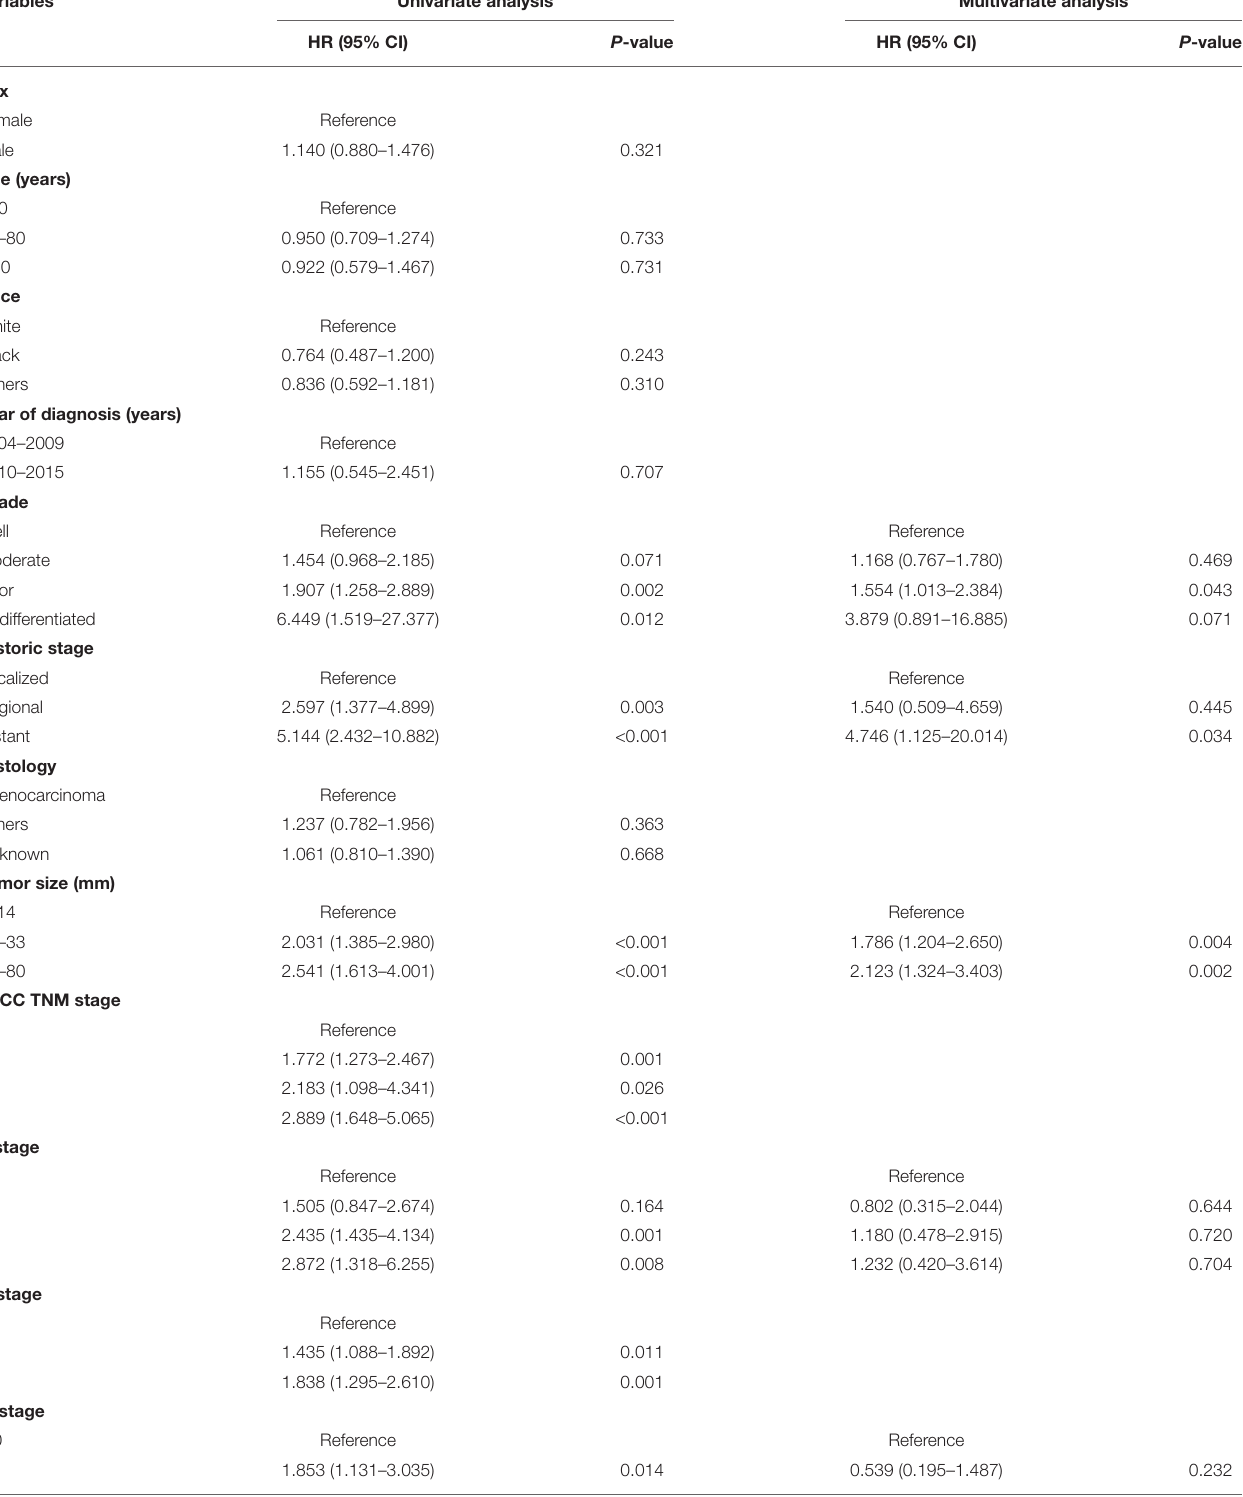
TABLE 2 | Uni- and multivariate analysis of prognostic factors associated with cancer-specific survival for patients in the training cohort with distal